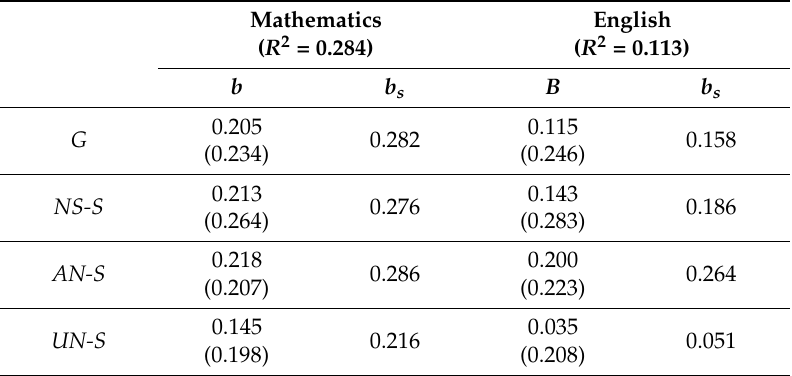
Table 3. Multivariate Regression Analyses with the Mathematics and English Grades as Dependent Variables and the g Factor and the Three Specific Factors as Independent